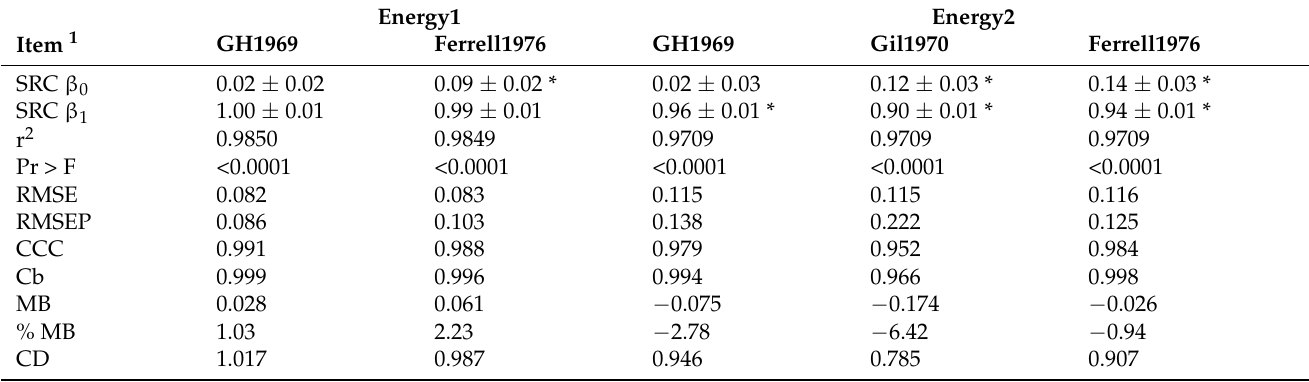
Table 7. Model evaluation of predicting empty body energy assuming empty body water is known, and predictive variables of the deviance between observed and predicted empty body chemical components in the Empty Body